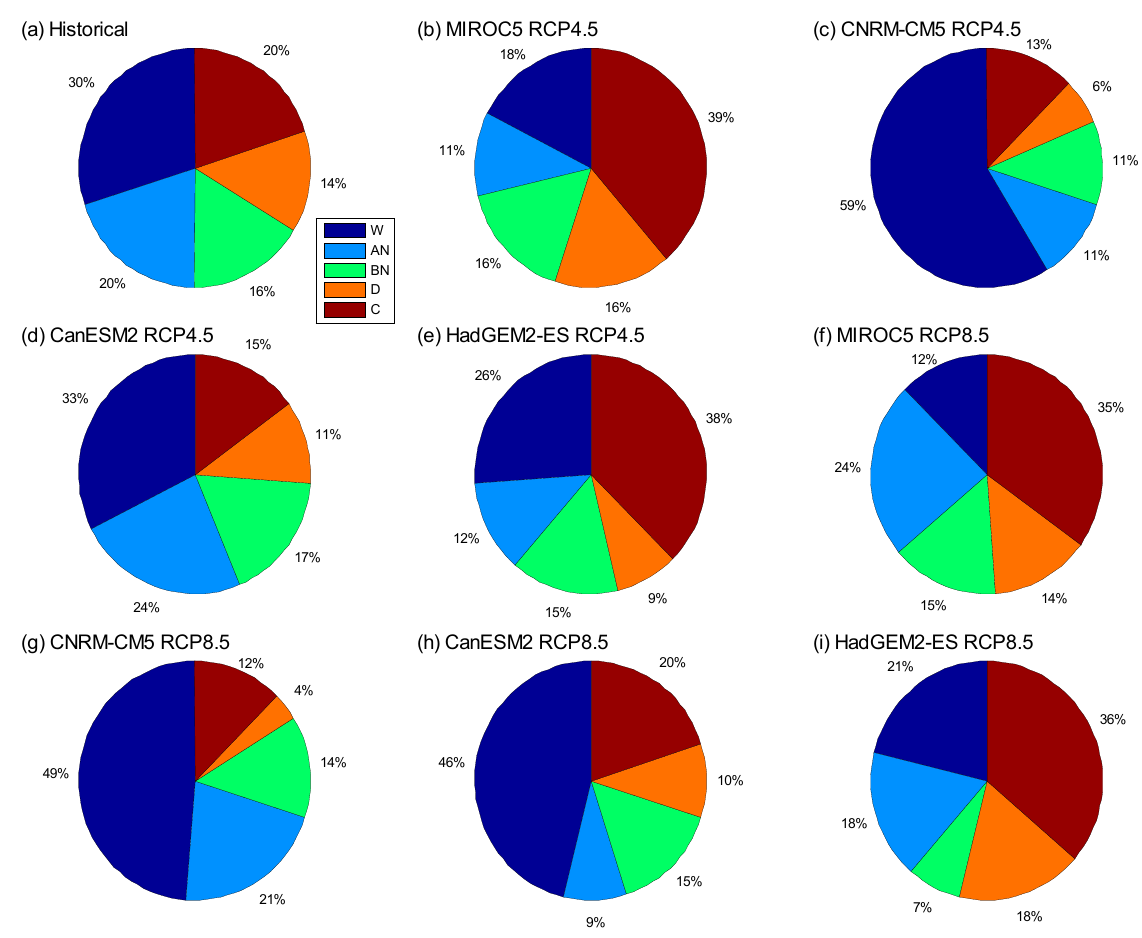
Figure 5. Historical and projected water year type distribution of SJQ4.